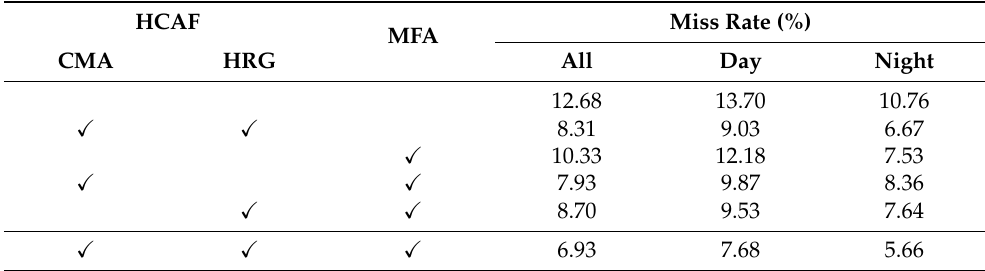
Table 4. Ablations on HAFNet. HCAF: Hierarchical content-dependent attentive fusion. MFA: Multi-modality feature alignment. CMA: Correlation-modality attention. HRG: Hierarchical reference